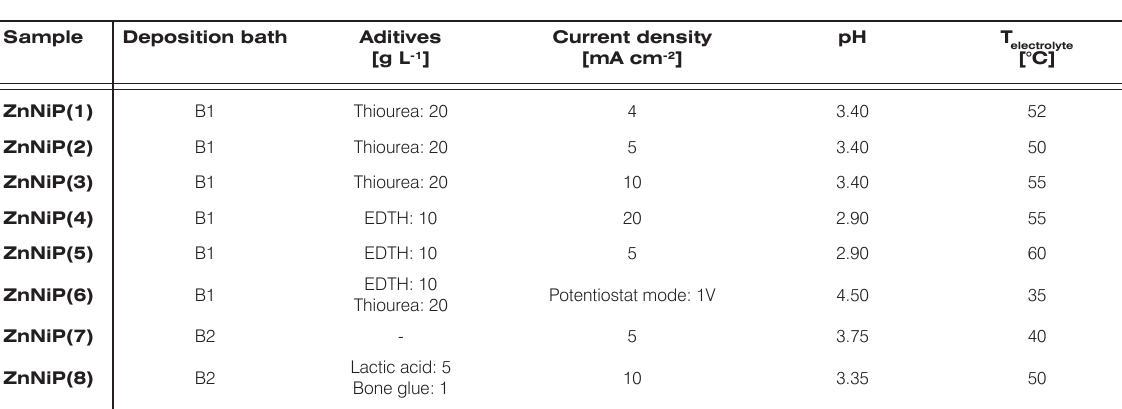
Table 2. Working parameters for sample manufacturing.